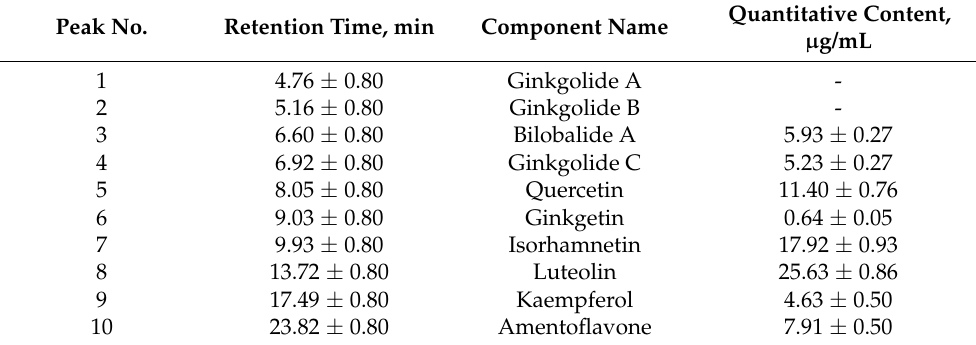
Table 2. The component composition of Ginkgo biloba extract according to HPLC data. Peak No.